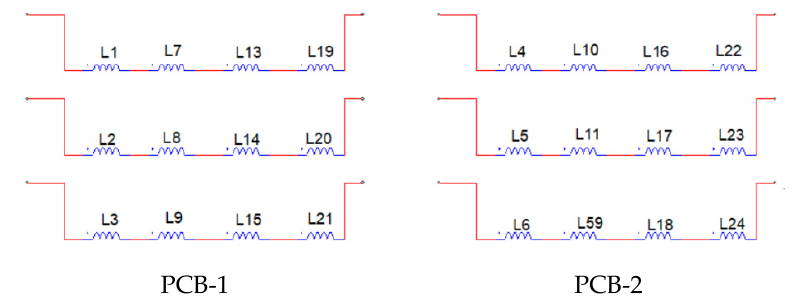
Figure 3. Stator coil connection arrangement for each stator.